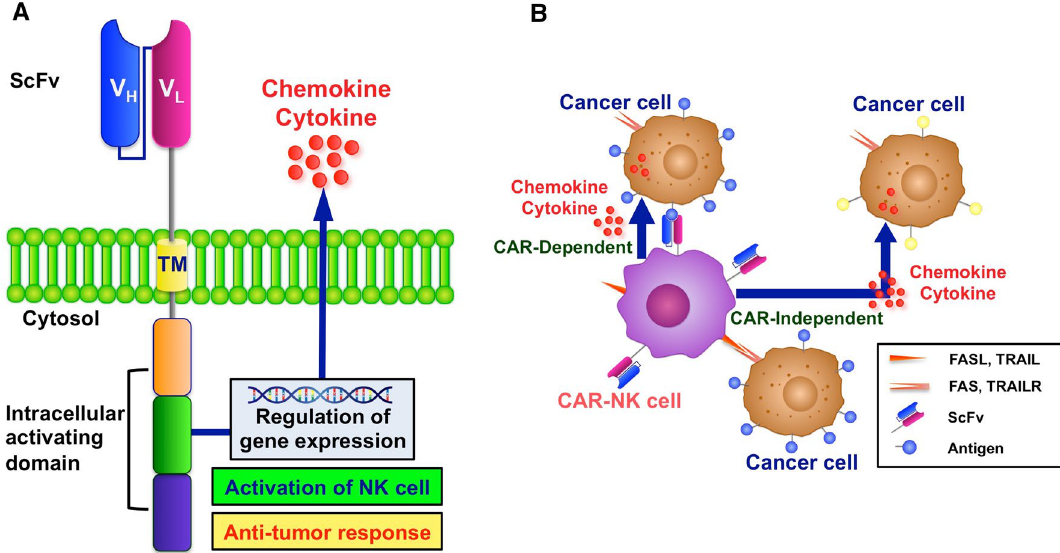
Fig. 1 Structure of chimeric antigen receptor (CAR)- Natural Killer (NK) cells and the manner of tumor cell elimination. A Functional struc- ture of CAR. CAR consists of three major sites: the extracellular region with a single-chain variable fragment (scFv), the intracellular region with a signal activating domain, and the transmembrane (TM) region that connects the extracellular and intracellular regions. ScFv recog- nizes tumor antigens that are overexpressed in cancer cells or expressed only in cancer cells. The TM region transduces activation signals recognized by scFv into intracellular activation signals. The intracellular activating domain regulates gene expression, which activates NK cells and stimulates chemokine and cytokine secretion. B The CAR-dependent or CAR-independent manner of tumor cell elimination. CAR- NK cells recognize tumor antigens and activated themselves. Activated CAR-NK cells produce secretory cytokines and chemokines. These are effective not only on CAR-recognized cells (CAR-dependent) but also on cancer cells that do not express the tumor antigens recognized by scFv (CAR-independent). Activated CAR-NK cells express FAS ligand (FASL) or TRAIL. FAS and TRAILR recognize FASL and TRAIL on the sur- face of cancer cells, respectively. These promote cancer cell apoptosis in a CAR-independent